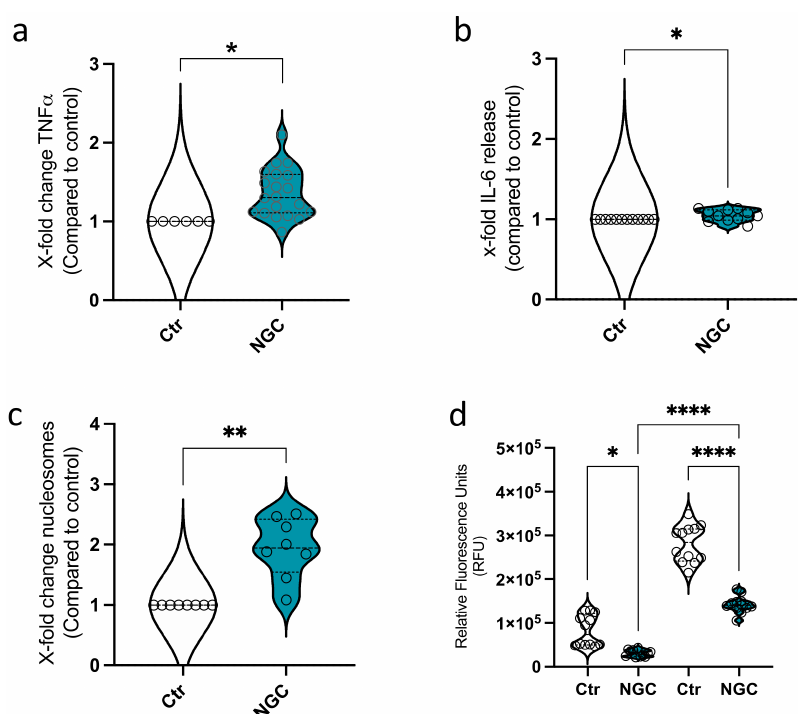
Figure 4. Interaction of primary monocytes with NGC. ( a ). Secretion of TNF α in response to NGC treatment. ( b ). IL-6 release from CD14 + monocytes in response to NGC. ( c ). Release of nucleosomes as an indication for ET formation. ( d ). Analysis of ROS production in CD14 + monocytes in response to NGC. All data represent mean +/ − SEM of 4–5 independent experiments. * p ≤ 0.05, ** p ≤ 0.01, **** p ≤